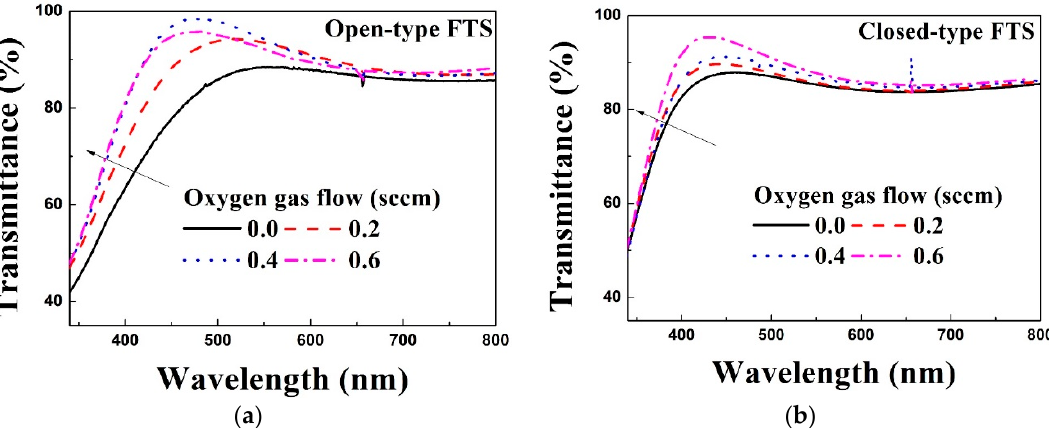
Figure 10. Optical transmittance spectra of ITO thin films deposited under different oxygen flow rates. ( a ) Open-type FTS and ( b ) Closed-type FTS.